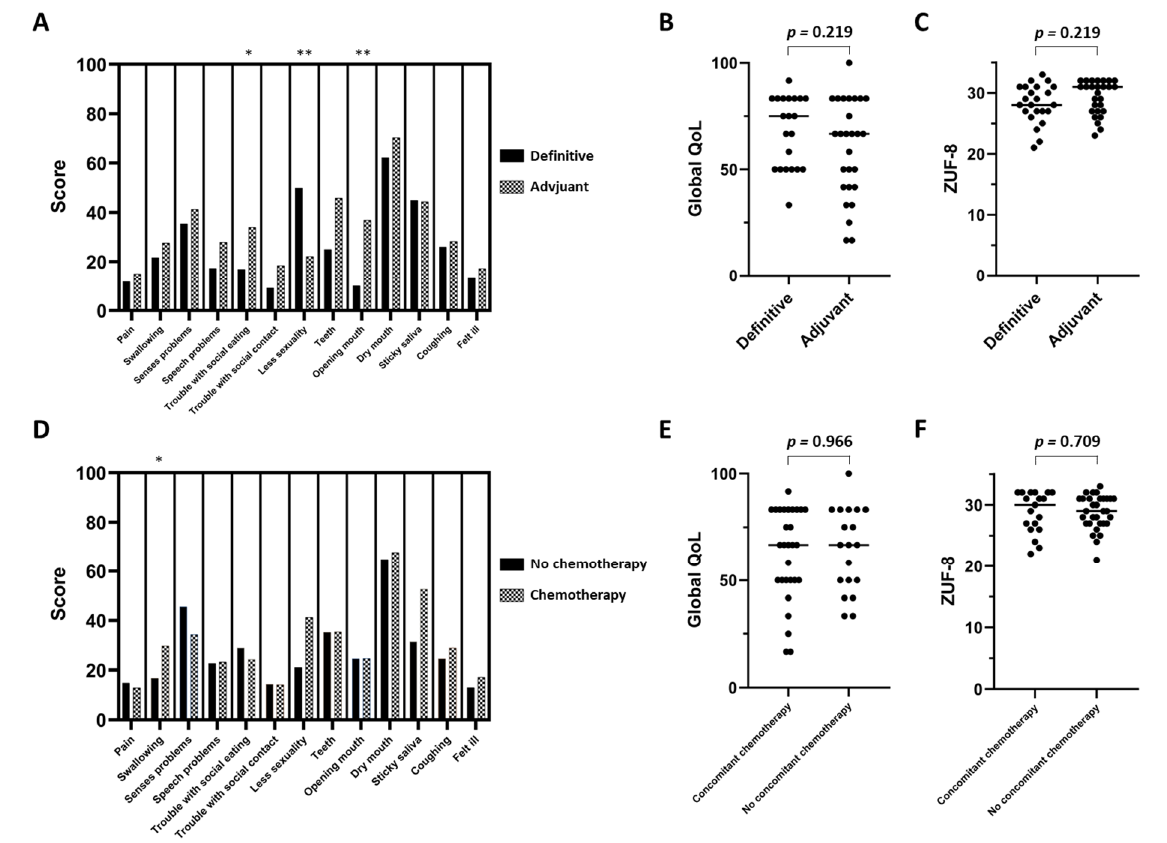
Figure 3. Comparison between the definitive and adjuvant (chemo)radiotherapy group regarding the different EORTC QLQ-H&N35 symptom subscales ( A ), general QoL ( B ) and patient satisfaction measured by the ZUF-8 questionnaire ( C ) of surviving elderly HNSCC patients. Influence of concomitant chemotherapy administration in surviving elderly HNSCC patients in terms of the EORTC QLQ-H&N35 symptom subscales ( D ), general QoL ( E ) and patient satisfaction ( F ). Groups were compared using Mann-Whitney U tests. * p < 0.05, ** p < 0.01.